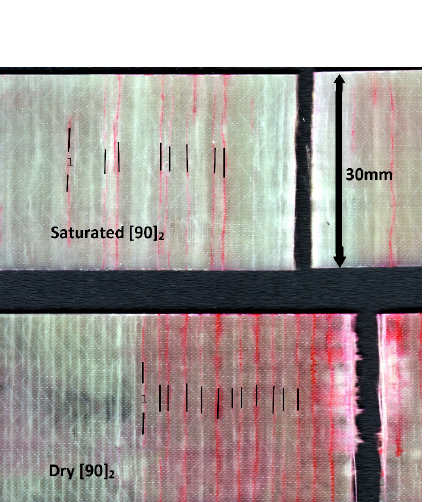
Figure 5. Stress–strain response of dry and saturated laminates.